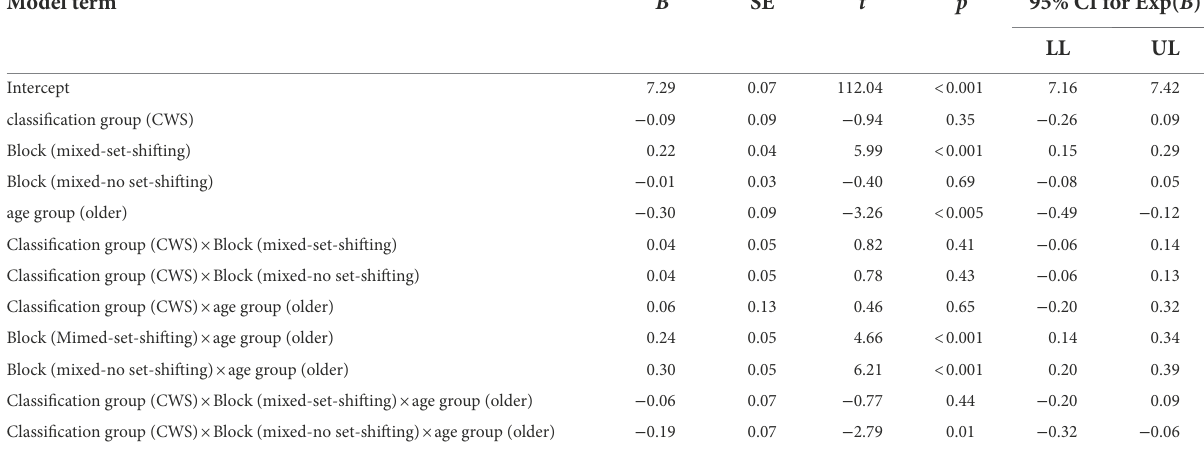
TABLE 3 Fixed effects of classification group, age group and block on response times (incompatible trials analysis).